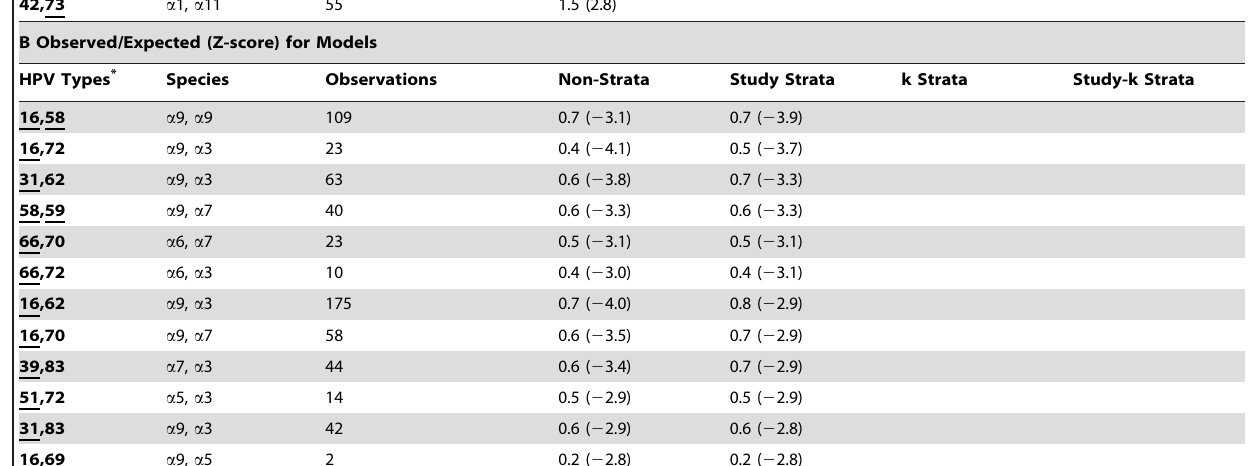
Table 2. Significant HPV Pairs.